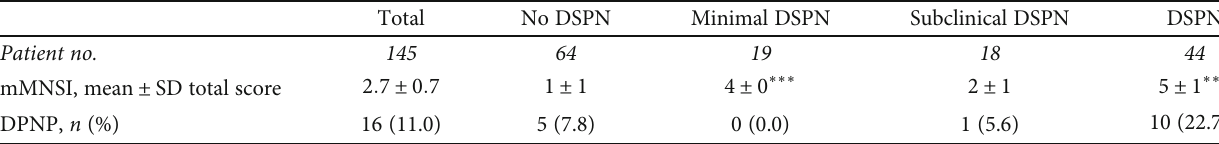
Table 1: Distribution of mMNSI total score and DPNP a rate by DSPN stage b